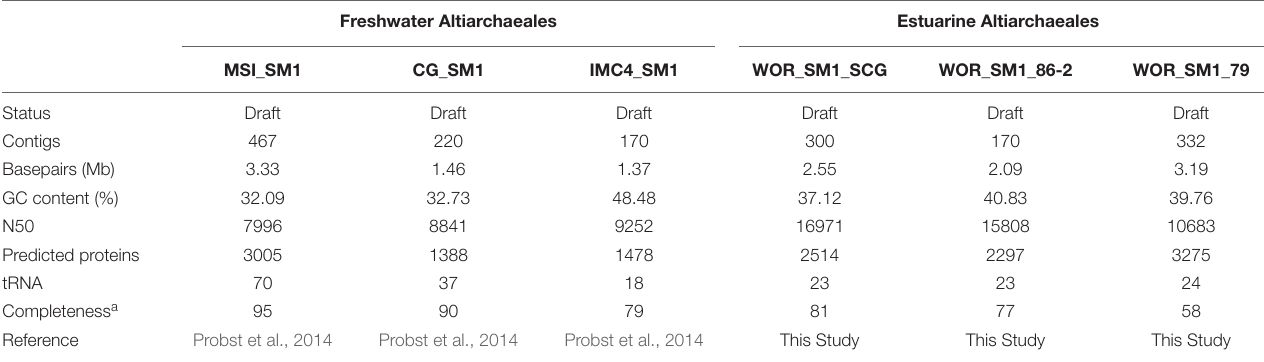
TABLE 1 | Statistics on genomes highlighted in this